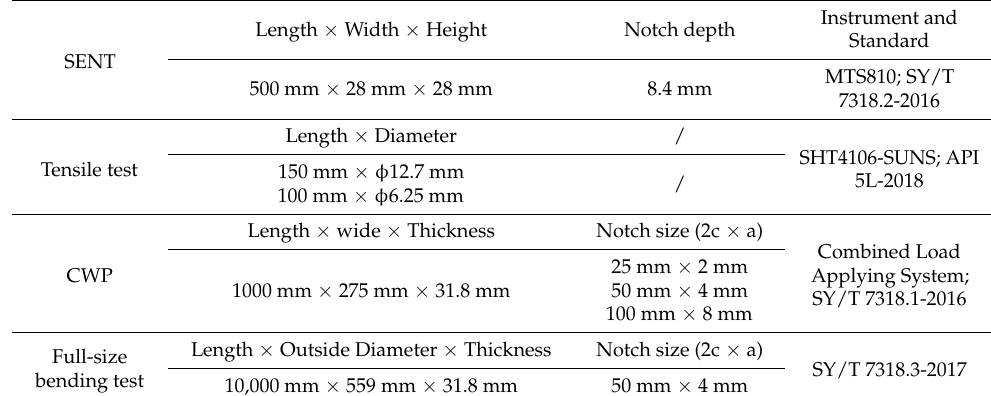
Table 1. The specimen size of SENT, tensile test, CWP and full-size bending.